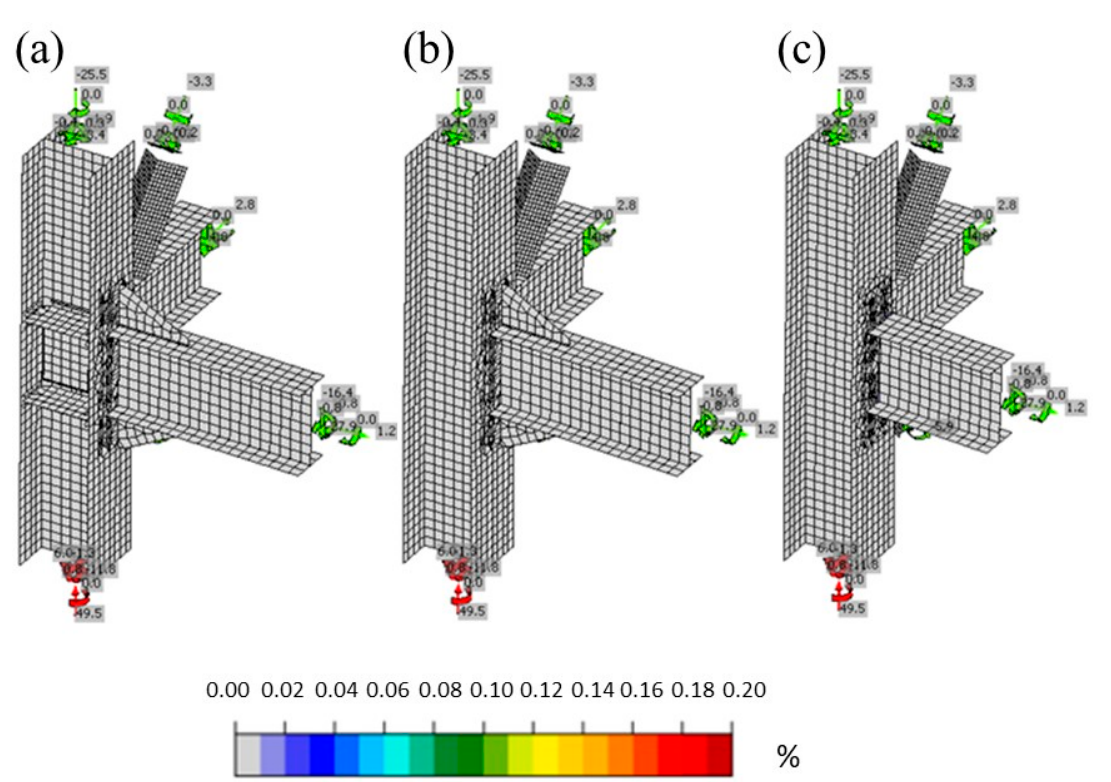
Figure 7. Strains computed on the connection for the three 8ES EPC models: ( a ) CP-DP-ST, ( b ) ST, and ( c ) NP.